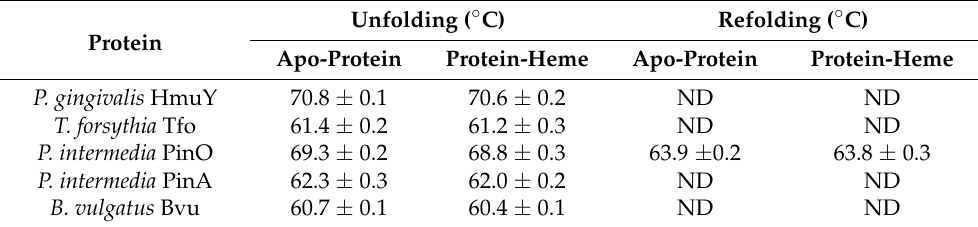
Table 1. Analysis of conformational stability of hemophore-like proteins. Thermal unfolding and refolding transition points (T m ) were determined from the first derivative of the changes in the emission wavelengths of tryptophan and tyrosine fluorescence at 330 nm and 350 nm using a label-free fluorometric analysis. Two independent measurements were performed. ND, not detected.